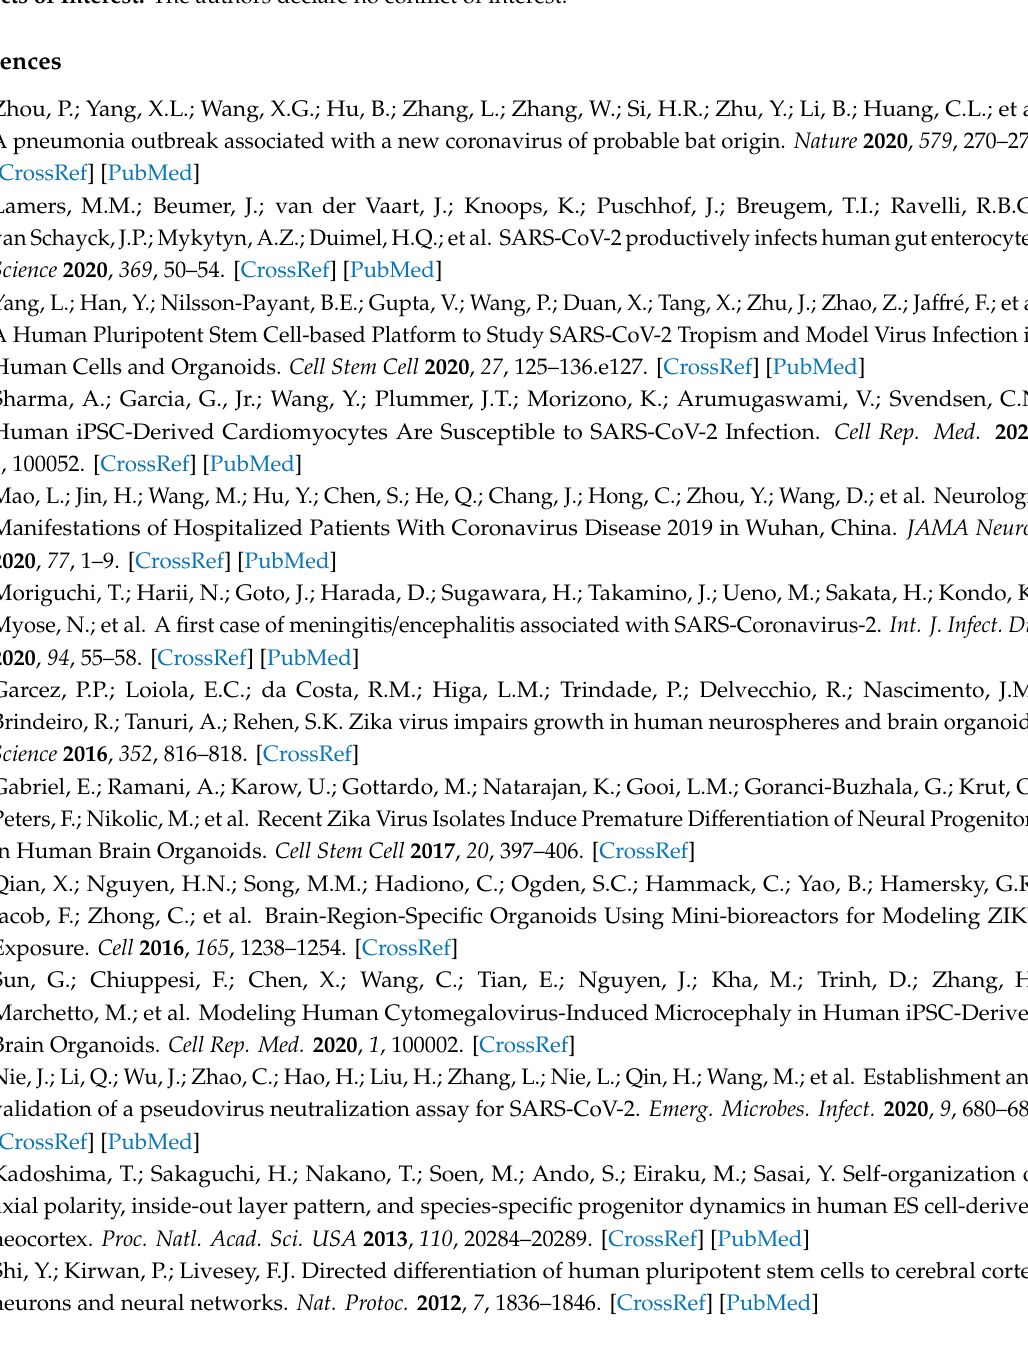
Figure S1: Generation of dorsal forebrain organoids from human embryonic stem